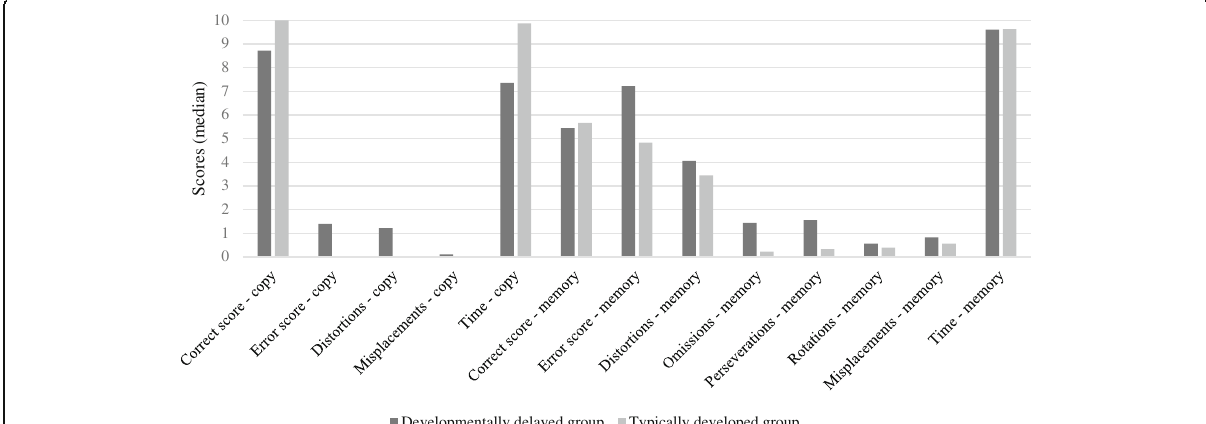
Fig. 1 Statistically significant differences between groups in BVRT task